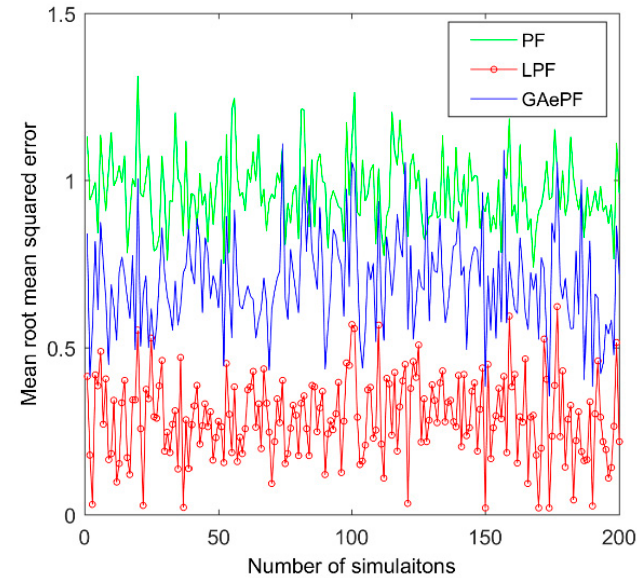
Figure 3. Mean rmse with simulation numbers of three algorithms compared. Table 1. Mean Root Mean Squared Error and Stop Time.